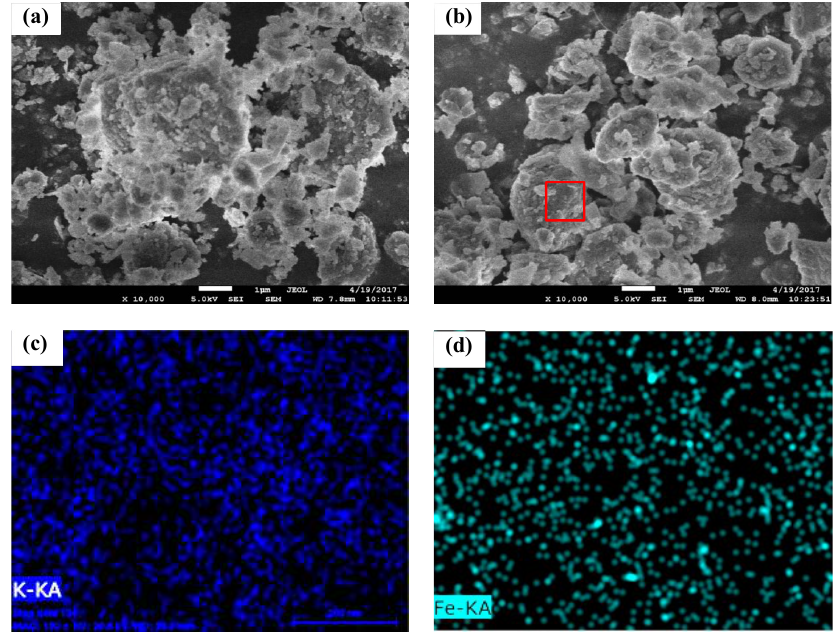
Figure 14. Scanning electron microscopy (SEM) images and energy dispersive spectrometer (EDS) analysis of the treated bauxite. ( a ): Bauxite roasted at 550 °C; ( b ): leaching residue; ( c ) and ( d ): EDS analysis for assigned zone.